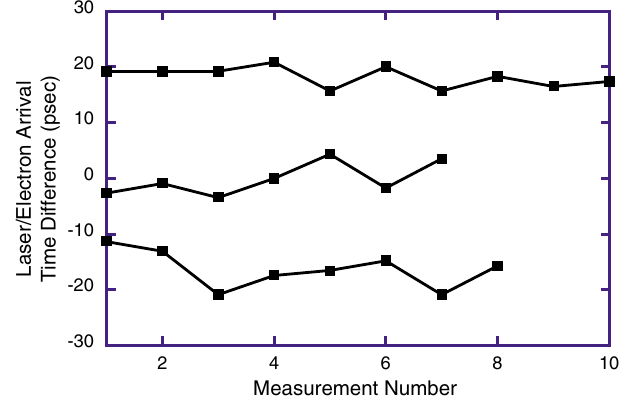
FIG. 31. (Color) Laser to electron beam timing jitter measure- ments taken at three different times. The shot-to-shot jitter is 2– 4 ps while the total drift from the two extreme data sets is 35 ps.